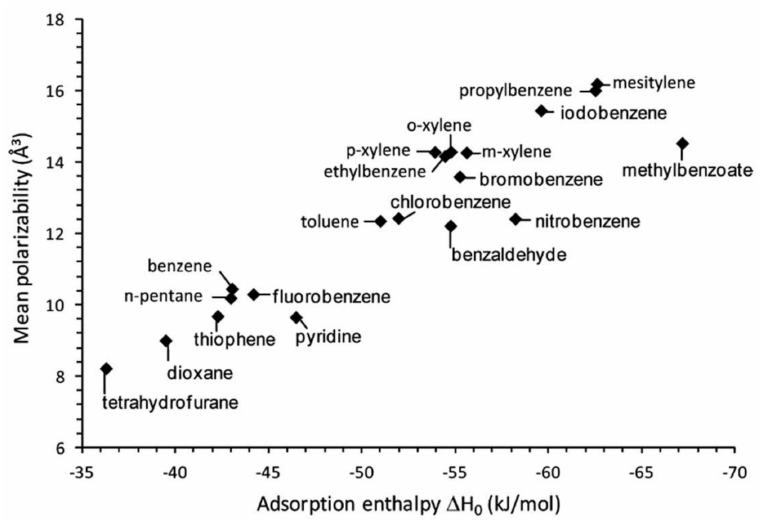
Figure 10. Relationship between mean molecular polarizability and adsorption enthalpy at zero coverage. Reprinted with permission from [61]. Copyright (2012) American Chemical